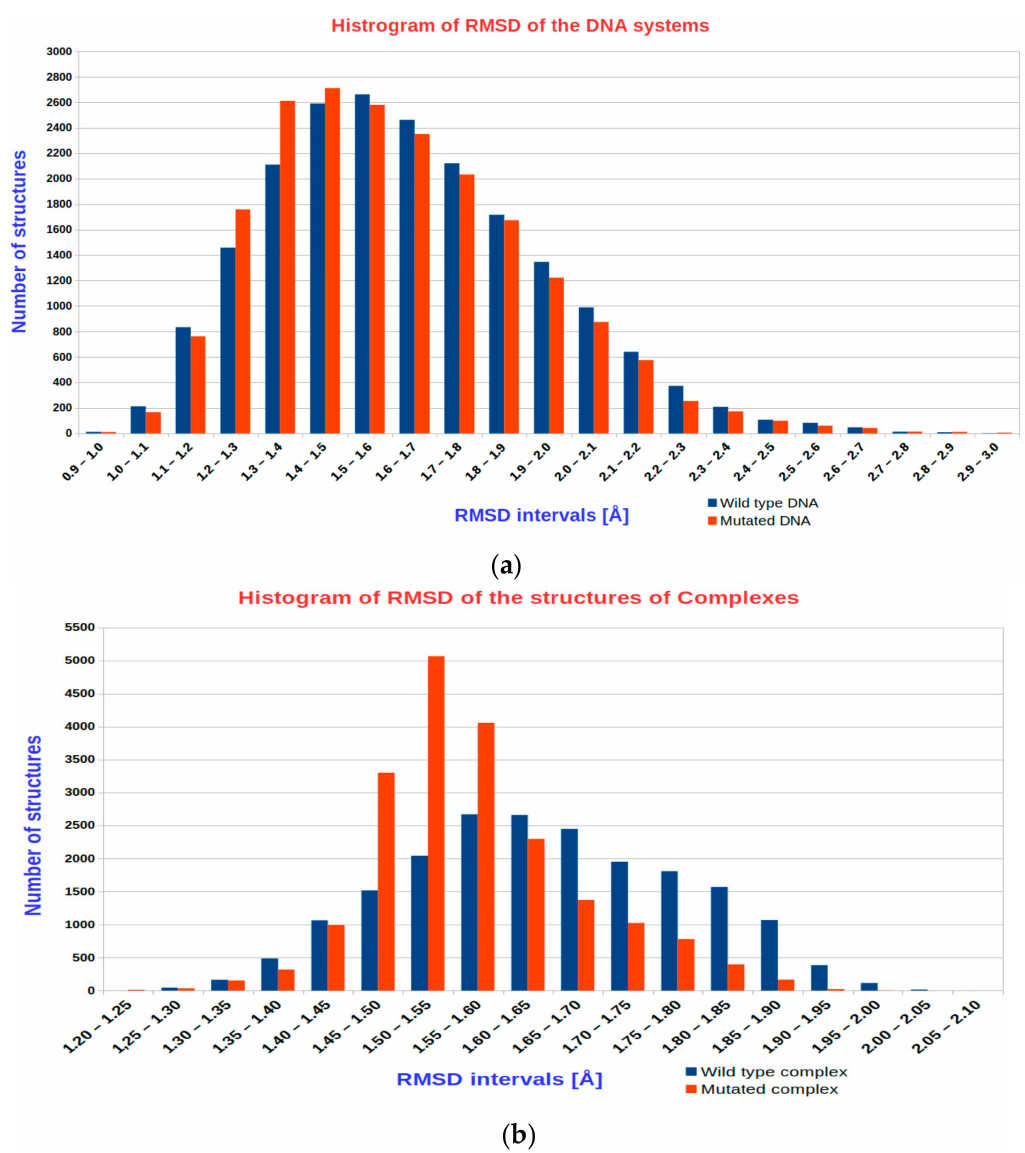
Figure 2. Histograms of root-mean-square di ff erence (RMSD) of atomic positions throughout 16 independent 5 ns molecular dynamics simulation production runs of the four investigated systems: ( a ) The wild-type DNA chain containing the HNF-1 α gene promotor sequence in blue, and the mutated DNA chain containing the HNF-1 α gene promotor sequence with the rSNP rs35126805 in red color; ( b ) the complex of transcription factor HNF-4 α bound to the wild-type DNA HNF-1 α gene promotor sequence in blue color, and the complex of transcription factor HNF-4 α bound to the mutated DNA HNF-1 α gene promotor sequence with the rSNP rs35126805 in red